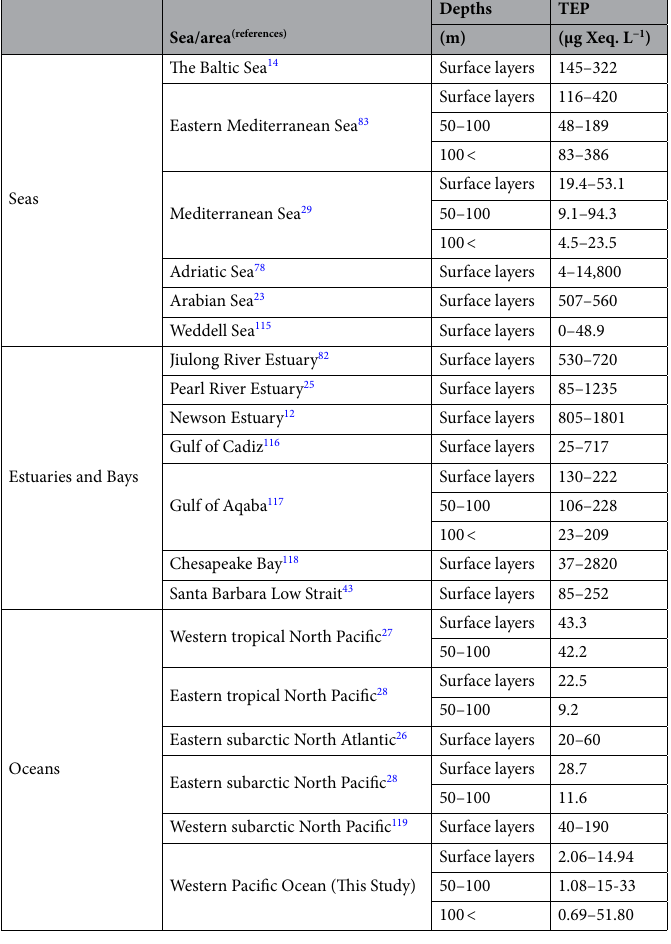
Table 2. TEPs in different layers of various waterbodies from different studies.